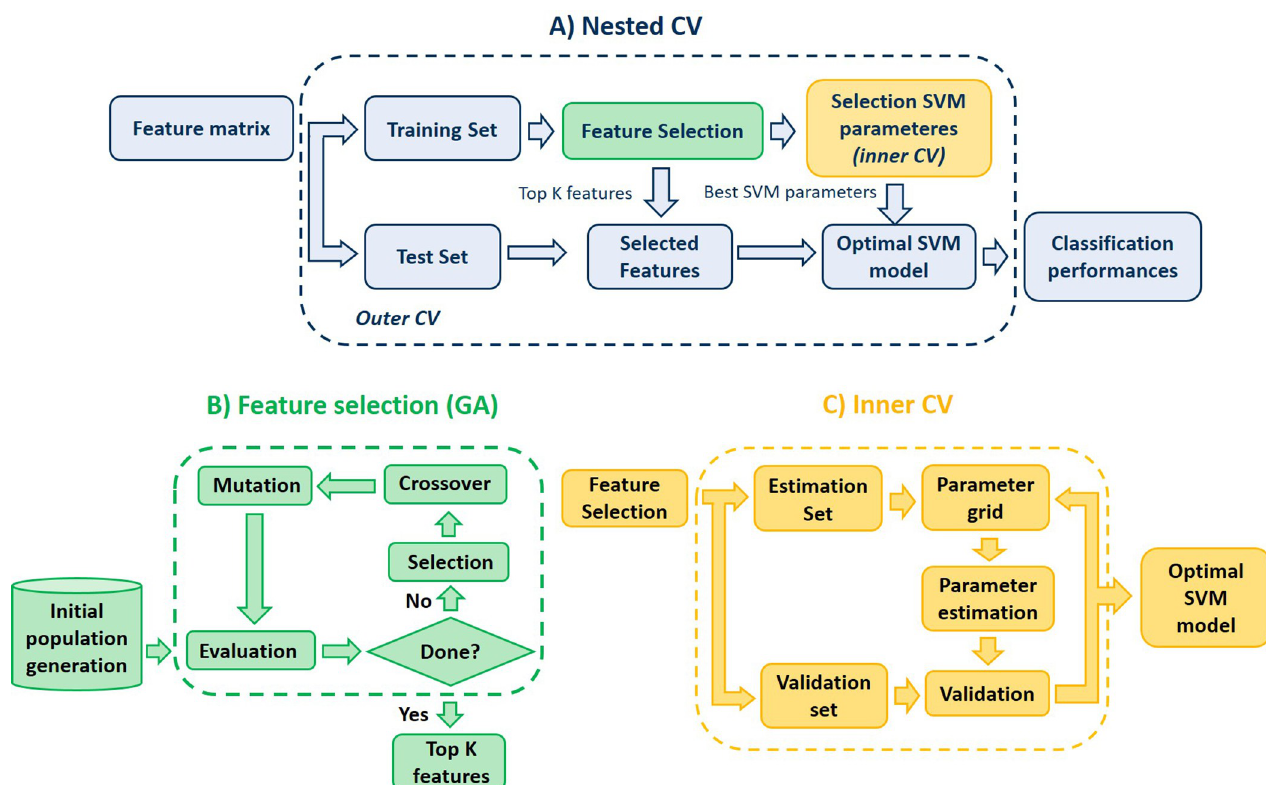
Fig 1. Nested CV procedure for model development and evaluation. (A) The outer loop consists of a 5-fold CV, used to evaluate the final model on the held out test set. This CV procedure is repeated 100 times. (B) The feature selection step consists of a genetic algorithm to select the optimal features in the classification problem. (C) The inner loop, consists of a 5-fold CV, employed to tune the parameters of the SVM.